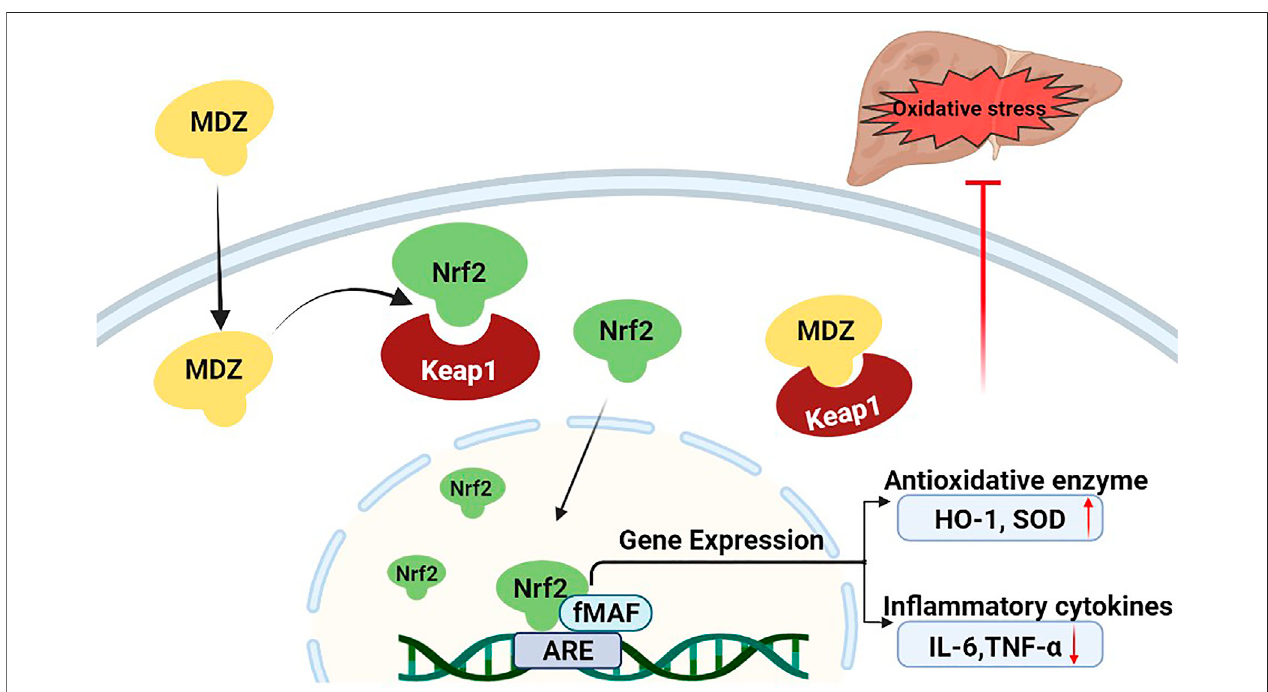
FIGURE 10 | Proposed mechanism of midazolam for ameliorating acute liver injury and related oxidative stress induced by CCL 4 . Under normal physiological conditions, the Nrf2 protein level is tightly controlled by Keap1. Upon oxidative stress treatment, midazolam can bind to Keap1 stably, and hinder the coalition between Keap1 and Nrf2.Nrf2isreleased and translocation tothenucleus tobindtoAREs andinitiate theanti-oxidative responsebyupregulatingtheexpression ofdownstream target genes including HO-1 and SOD, which then decreases intracellular ROS production and alleviates oxidative stress-induced cytotoxicity. Midazolam ameliorates acute liver injury induced by carbon tetrachloride via enhancing Nrf2 signaling